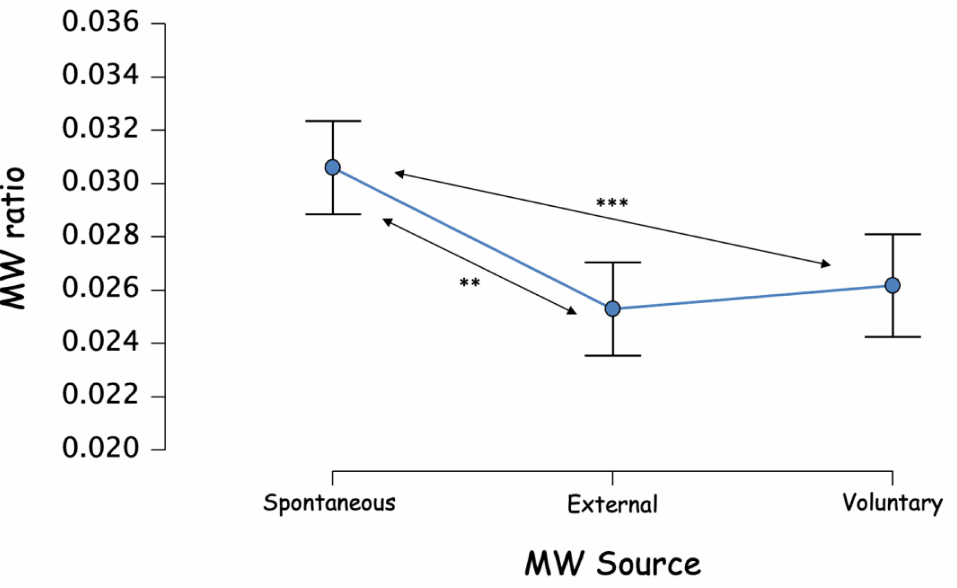
Figure 4. MW source frequency, calculated on all thought probes. ** p < 0.01, *** p <